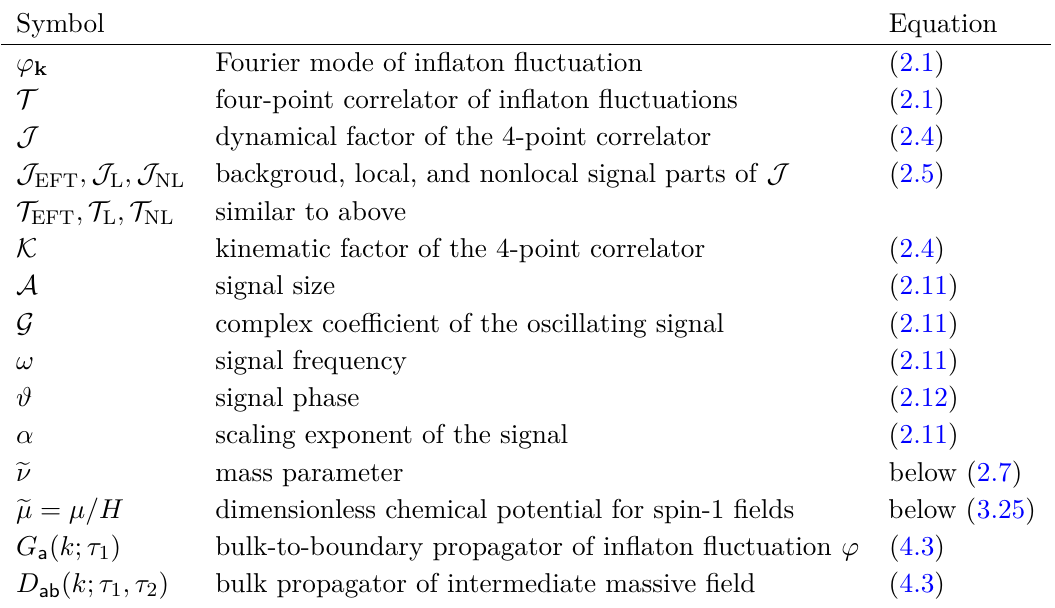
Table 1 . List of